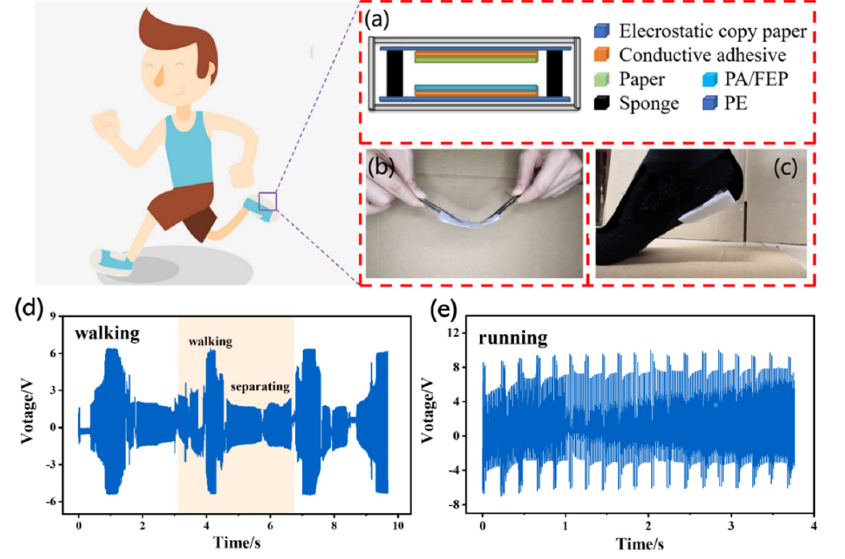
Figure 12. Structure diagram of the wearable device ( a – c ); open circuit voltage during walking ( d ); open circuit voltage during running ( e ).